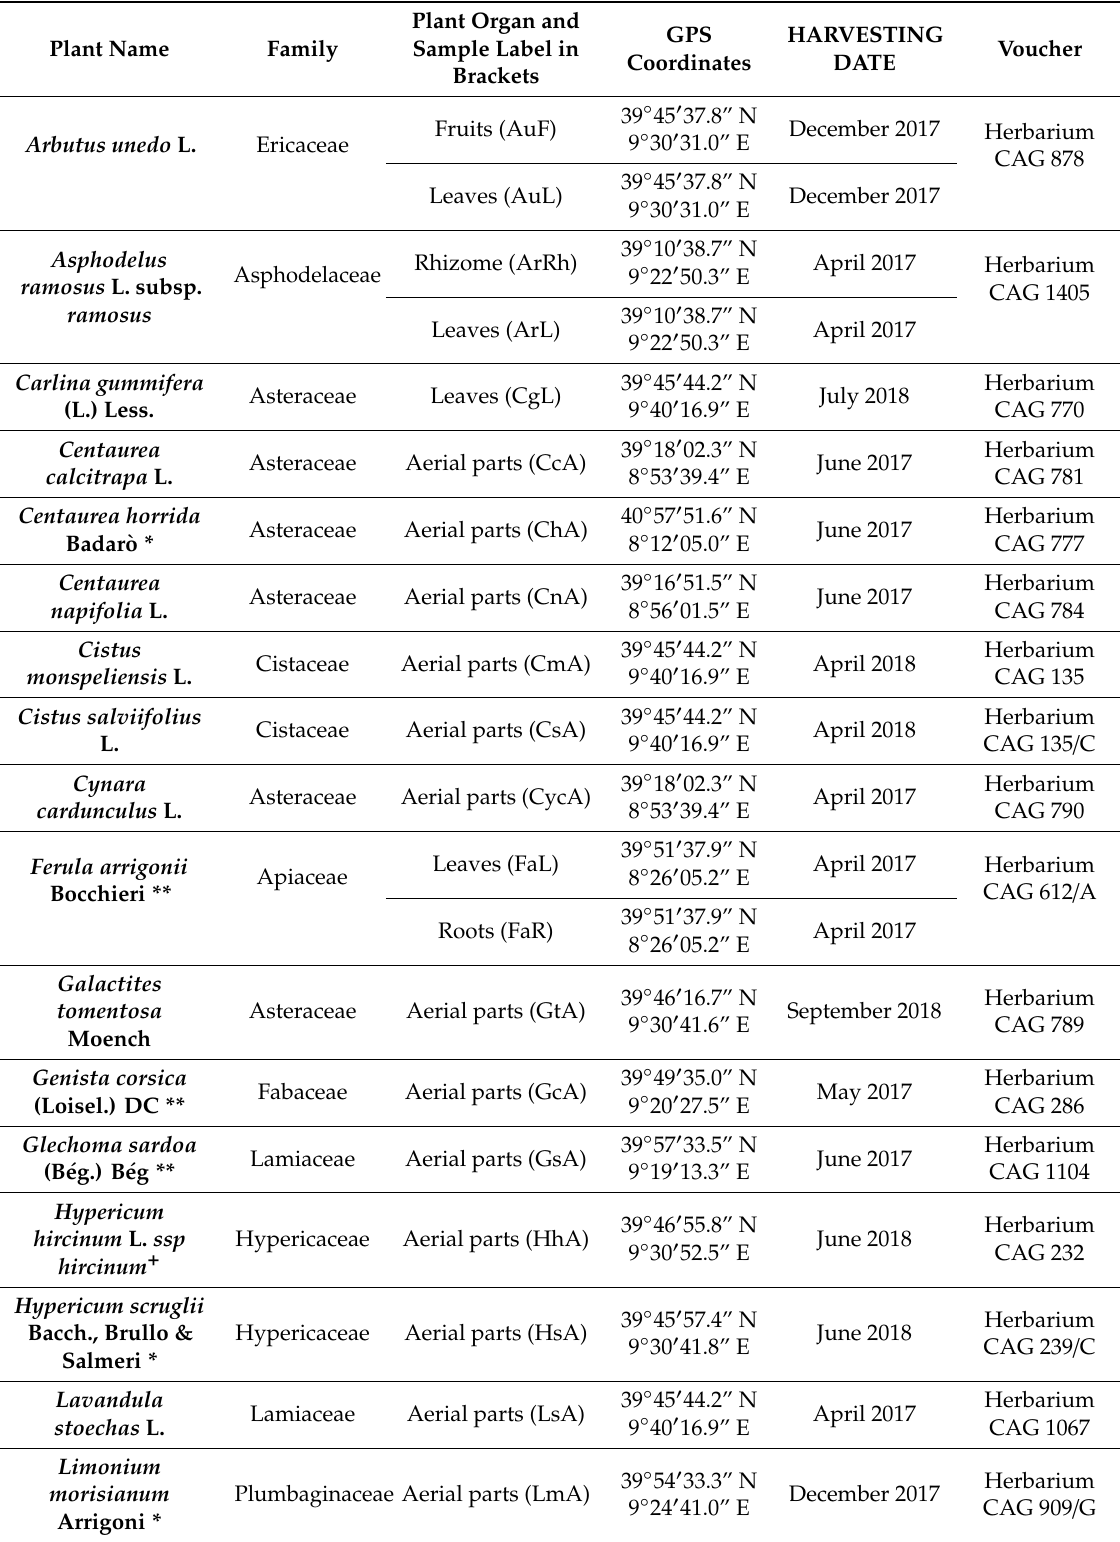
Table 4. List of the plants analyzed in this work. Plant name, family, considered plant organ and adopted label, harvesting date and GPS coordinates, and voucher number are